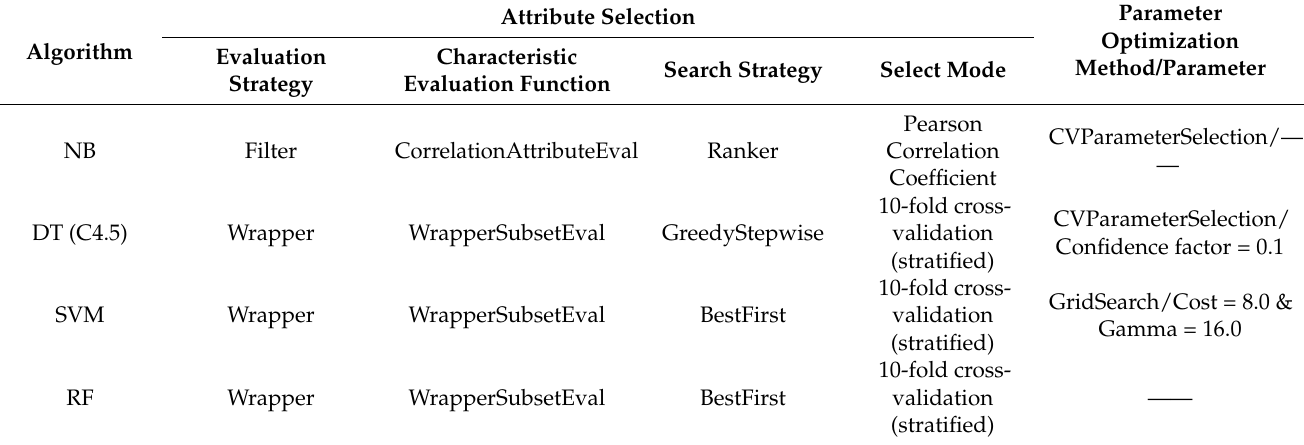
Table 3. Attribute selection strategy and the parameter optimization method used in this